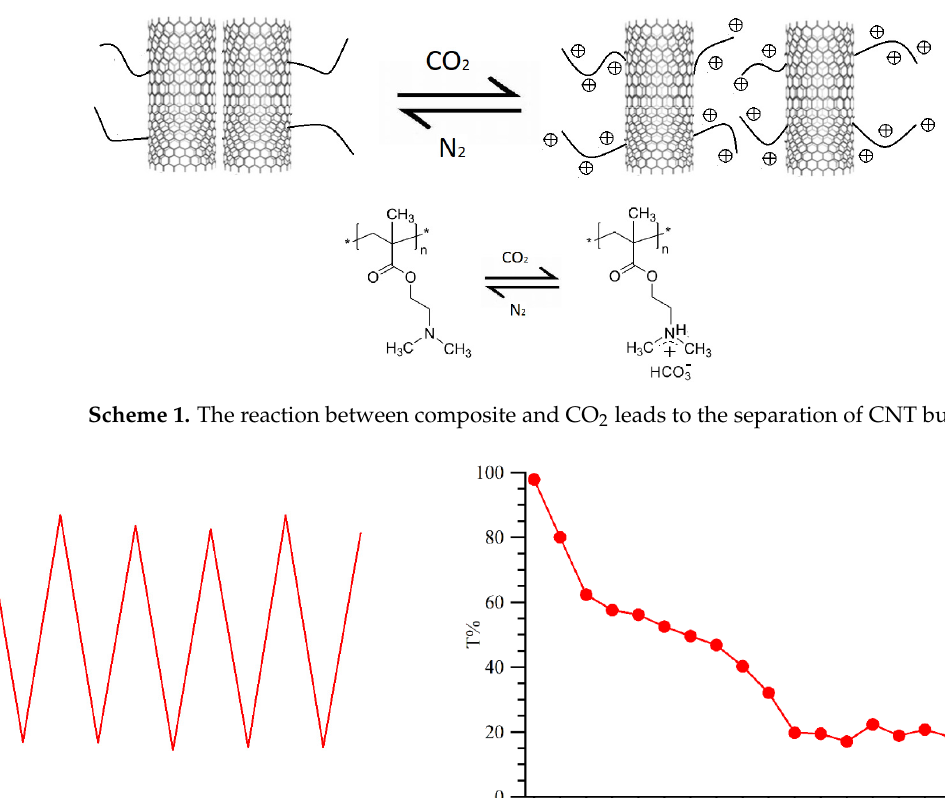
Figure 4. UV-Vis spectra of MWCNT-PDA-PDMAEMA in water, inset ( a ) before CO 2 purge and ( b ) after CO 2 purge.